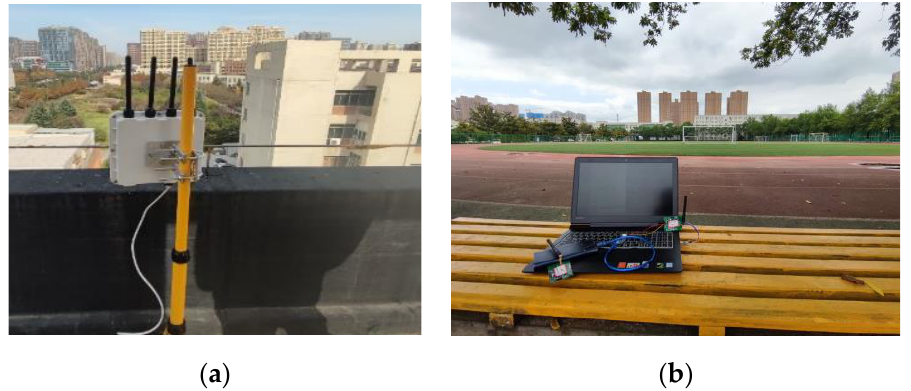
Figure 4. Outdoor test scenario. ( a ) The actual deployment location of the gateway; ( b ) Packet collection scenario.